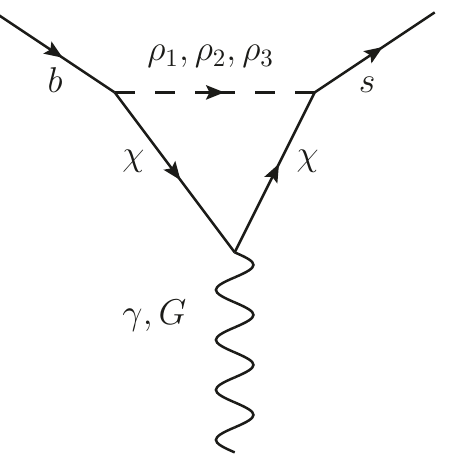
Figure 3 . The possible electromagnetic and chromomagnetic penguin diagrams that are con- tributed to the decay B X s (cid:13) in addition to the !